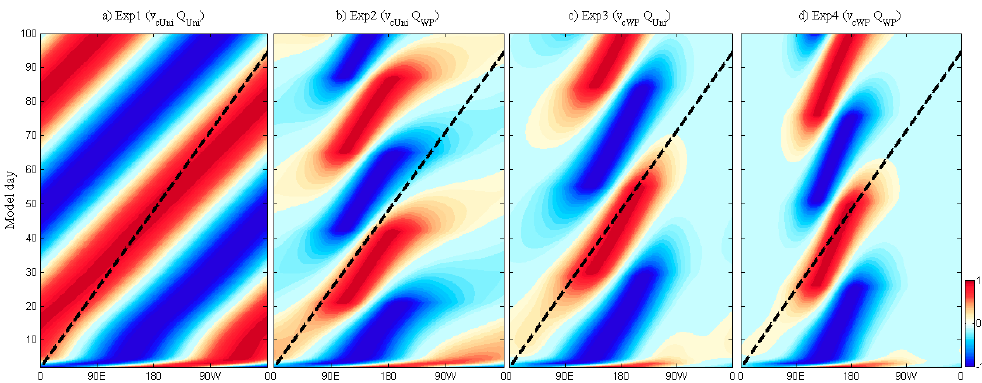
Figure 7. Zonal propagation changed by using different mean states. Hovemöller plots of normalized equatorial precipitation in: ( a ) Exp 1; ( b ) Exp 2; ( c ) Exp 3; and ( d ) Exp 4. The dashed line shows the reference speed of 5 m/s. The equatorial precipitation of each day is normalized by its maximum value.